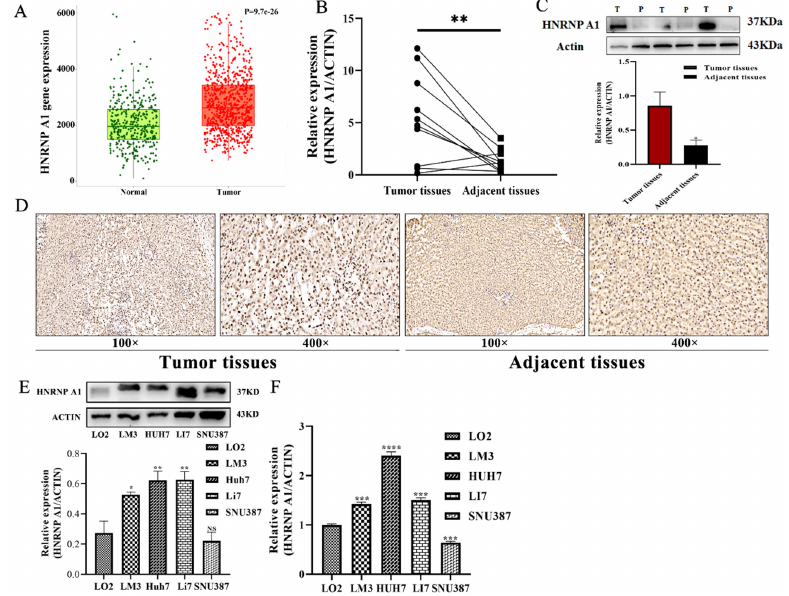
Figure 1. The expression of HNRNP A1 in HCC tissues, HCC cells, and the proliferation of HCC cells. ( A ) The expression levels of HNRNP A1 in HCC tissues and normal liver tissues in TNMplot; ( B , C ) the expression levels of HNRNP A1 in 10 pairs of human HCC tissues and adjacent normal tissues were detected using qPCR and WB; ( D ) the expression of HNRNP A1 in HCC tissues and adjacent normal tissues were detected by immunohistochemistry, n = 5; ( E , F ) the expression levels of HNRNP A1 in HCC cells and LO2 cells. * p < 0.05; ** p < 0.01; *** p < 0.001; **** p < 0.001; NS, not significant. The data are expressed as the mean ± SD.